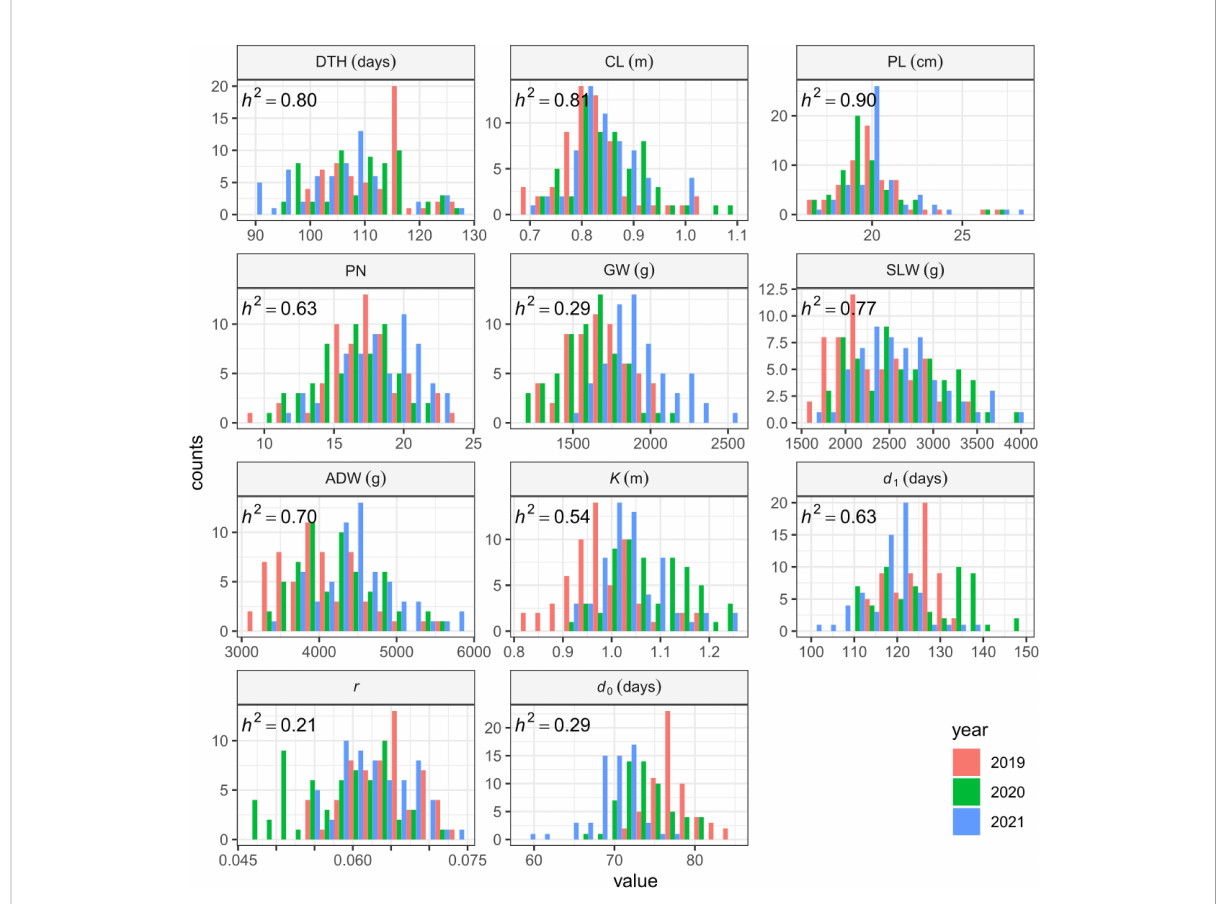
FIGURE 4 Frequency distributions of manually measured traits and CH-related parameters, shown as histograms.